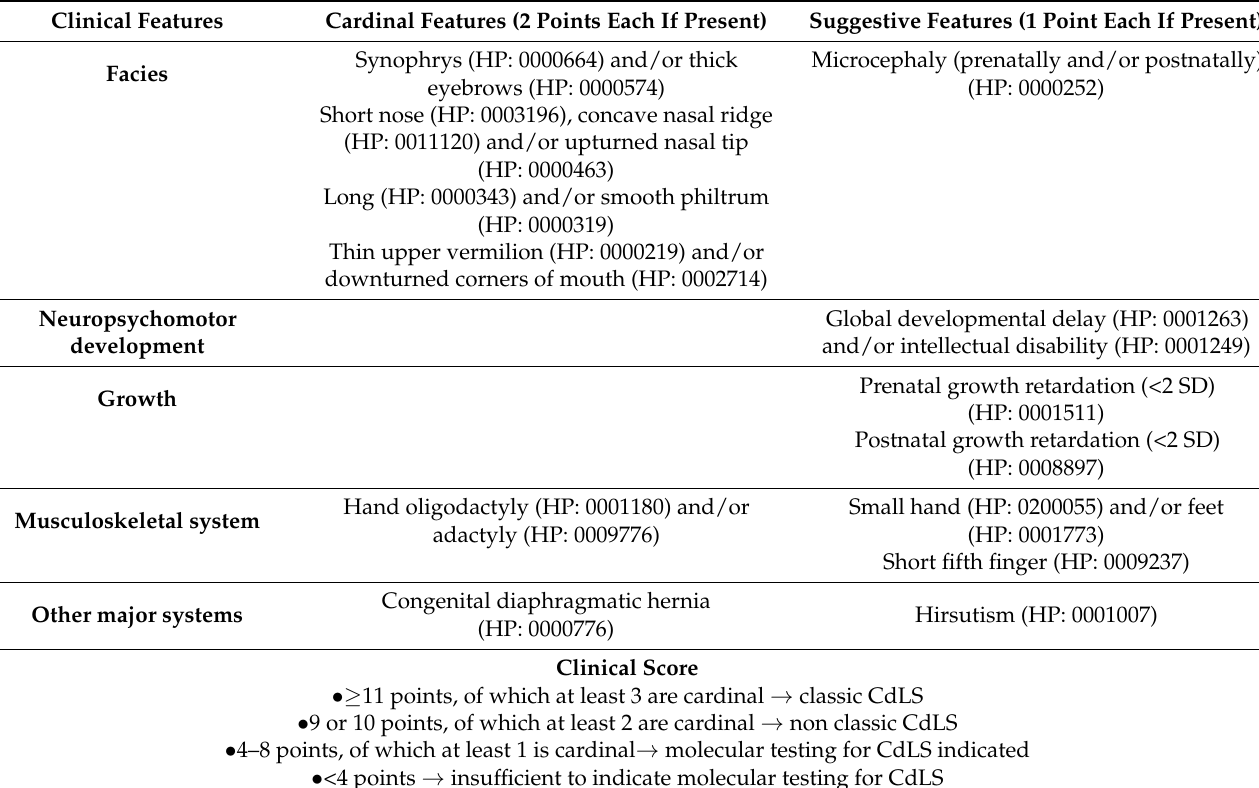
Table 1. Clinical features of Cornelia de Lange Syndrome (CdLS)